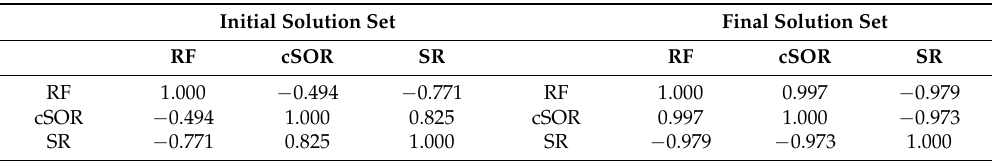
Table 8. Correlation coefficients between performance indicators obtained from the initial and final solutions of the hybrid multi-objective optimization